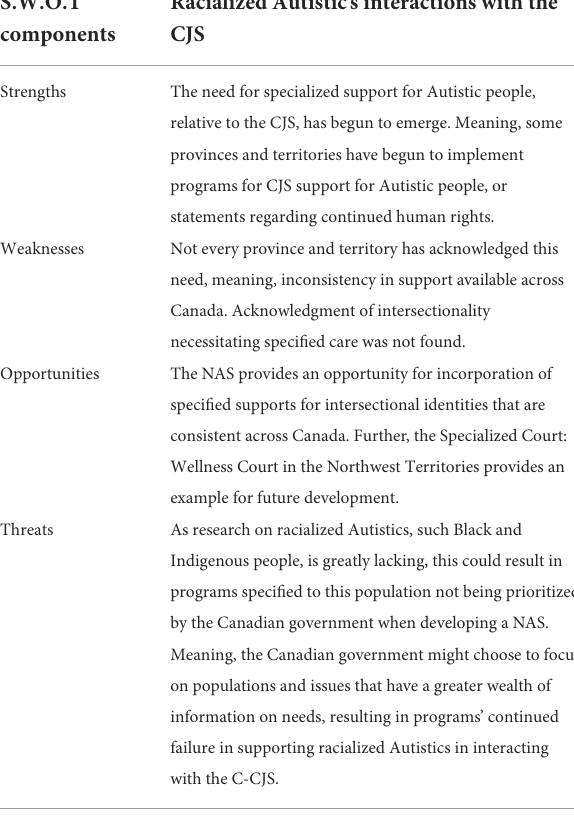
TABLE 5 Summary of S.W.O.T analysis for gray literature search on how indigenous and black communities uniquely interact with Canadian systems and